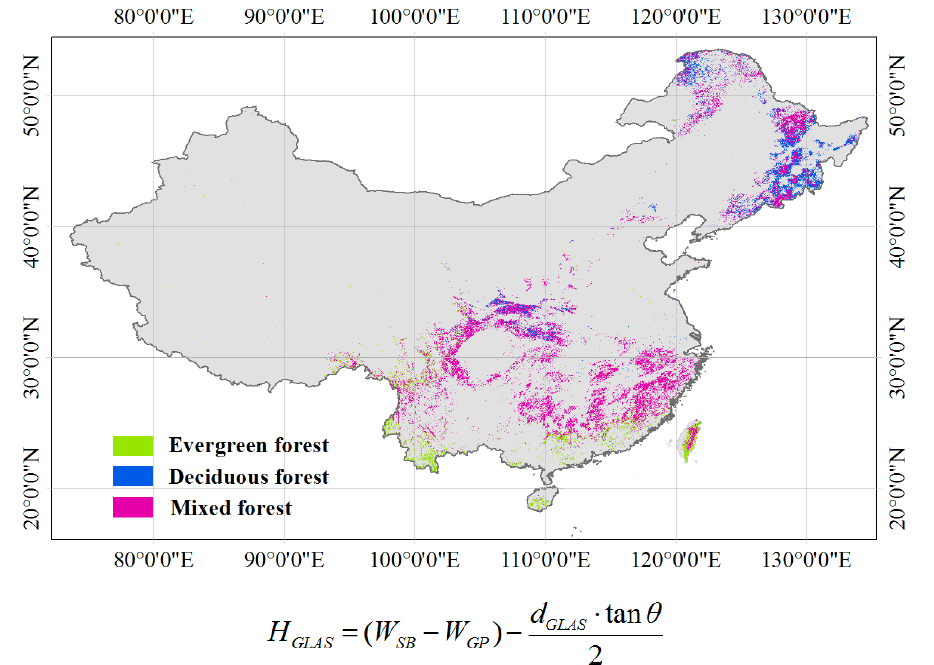
Figure 1. Forested area defined by the MODIS LC (MCD12Q1) and VCF (MOD44B) products. Three aggregated forest types (evergreen, deciduous, and mixed forests) with percent tree cover ( ≥ 50%) were considered in this